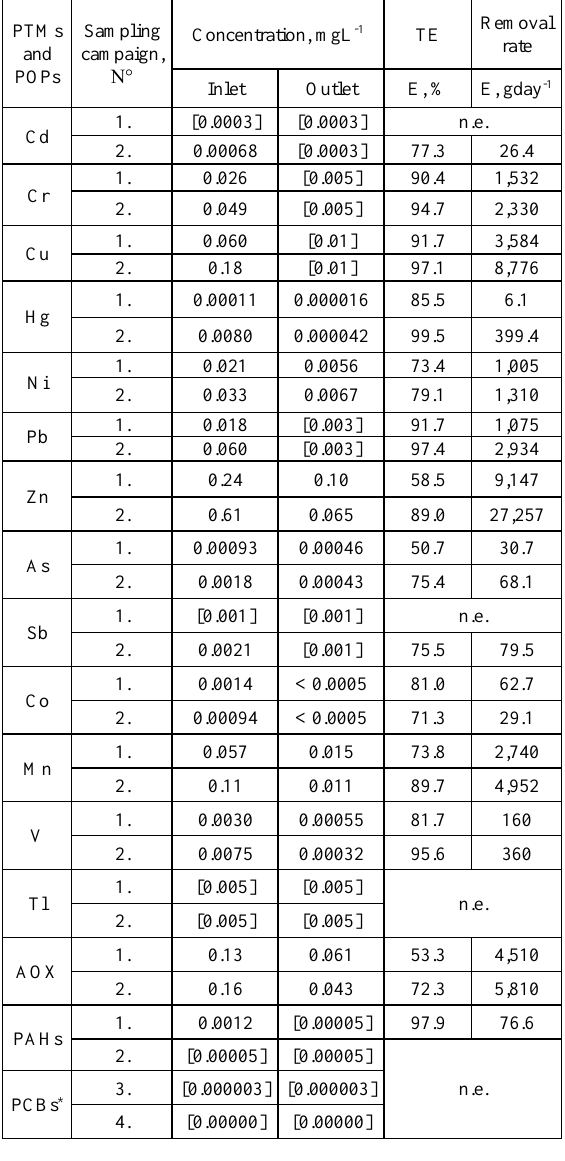
Table 1. Wastewater treatment efficiency (TE) estimation (E) for